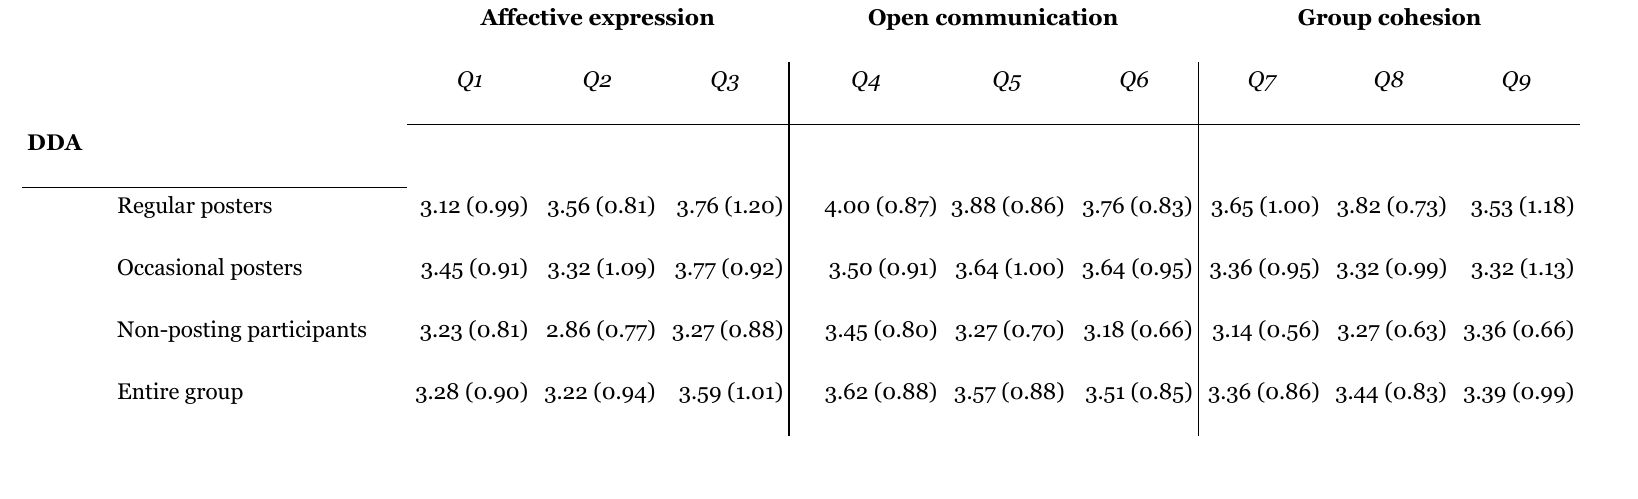
Mean (SD) Values for Social Presence Survey Question